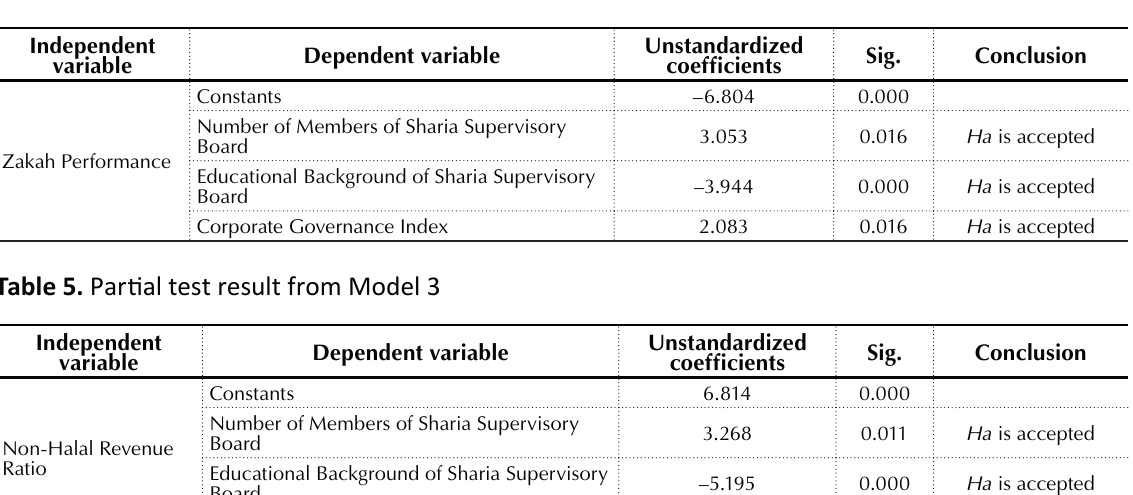
Table 4. Partial test result from Model 2